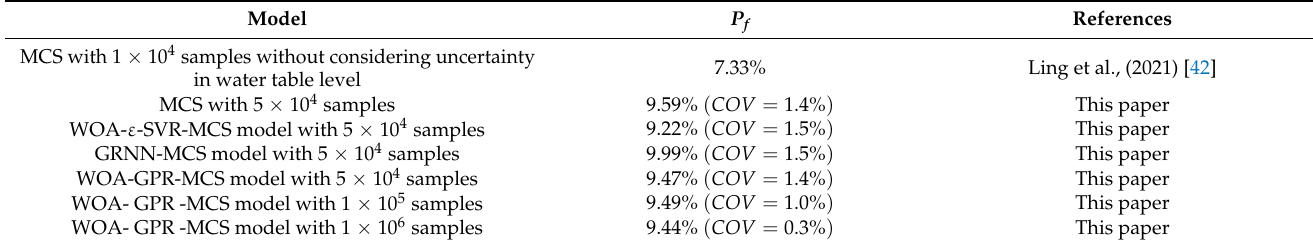
Table 11. Comparison between the dynamic WOA-GPR models with published